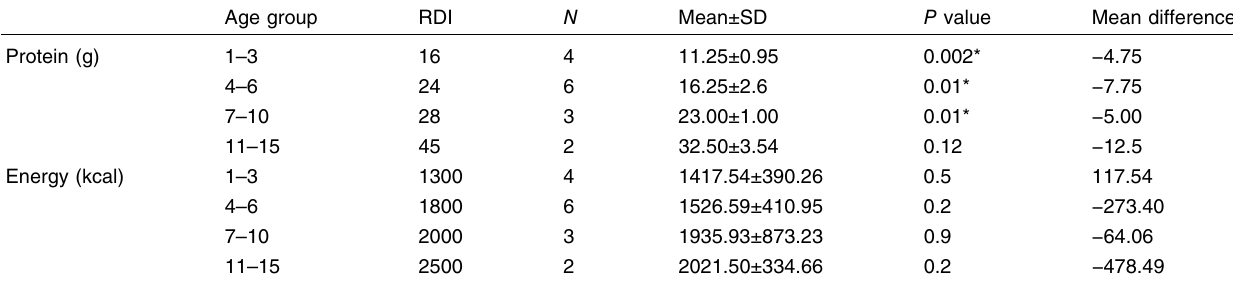
Table 6 Daily protein and energy intake of patients with CF Age group RDI N Mean±SD P value Mean difference Protein (g)